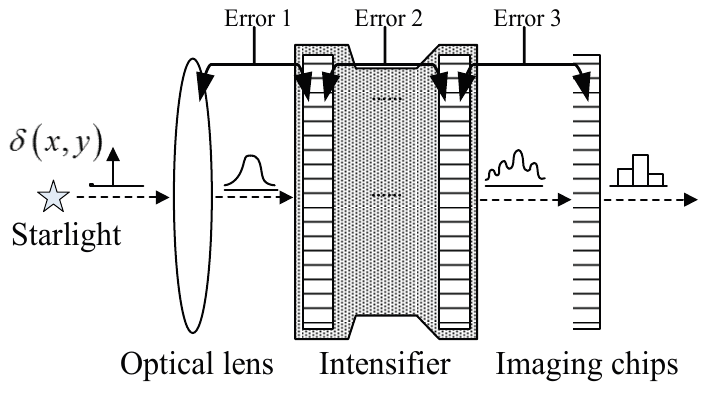
Figure 2. Diagram of the FOFP-induced systematic centroid